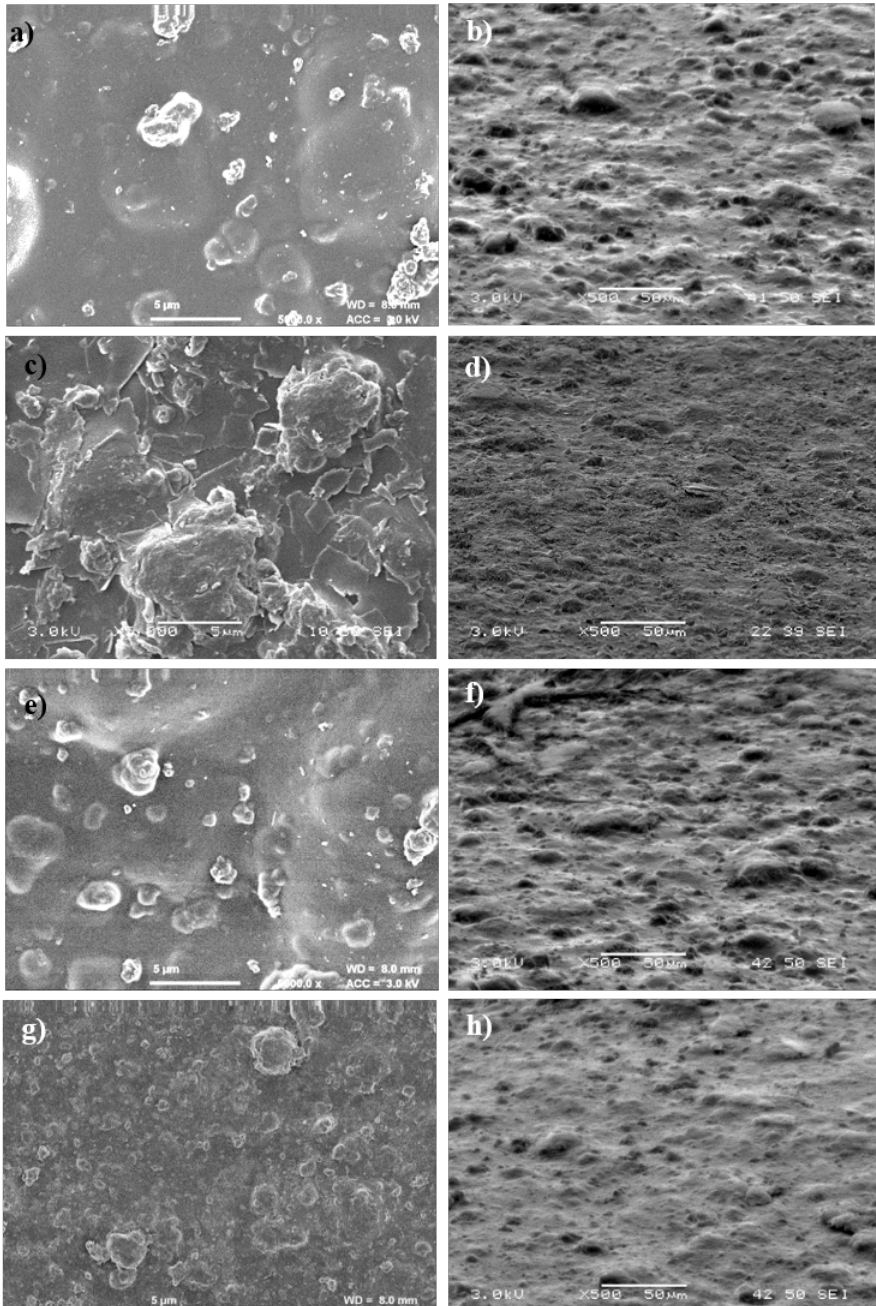
Figure 3. SEM pictures of hydrophobizing agent-coated cellulose–CaSiO 3 composites ( a ) before coating, after coating with ( c ) TOS, ( e ) E2CA, ( g ) ODPA (scale bar 5 µm) and ( b , d , f , h ) are the corresponding 65° tilted surface images (scale bar 50